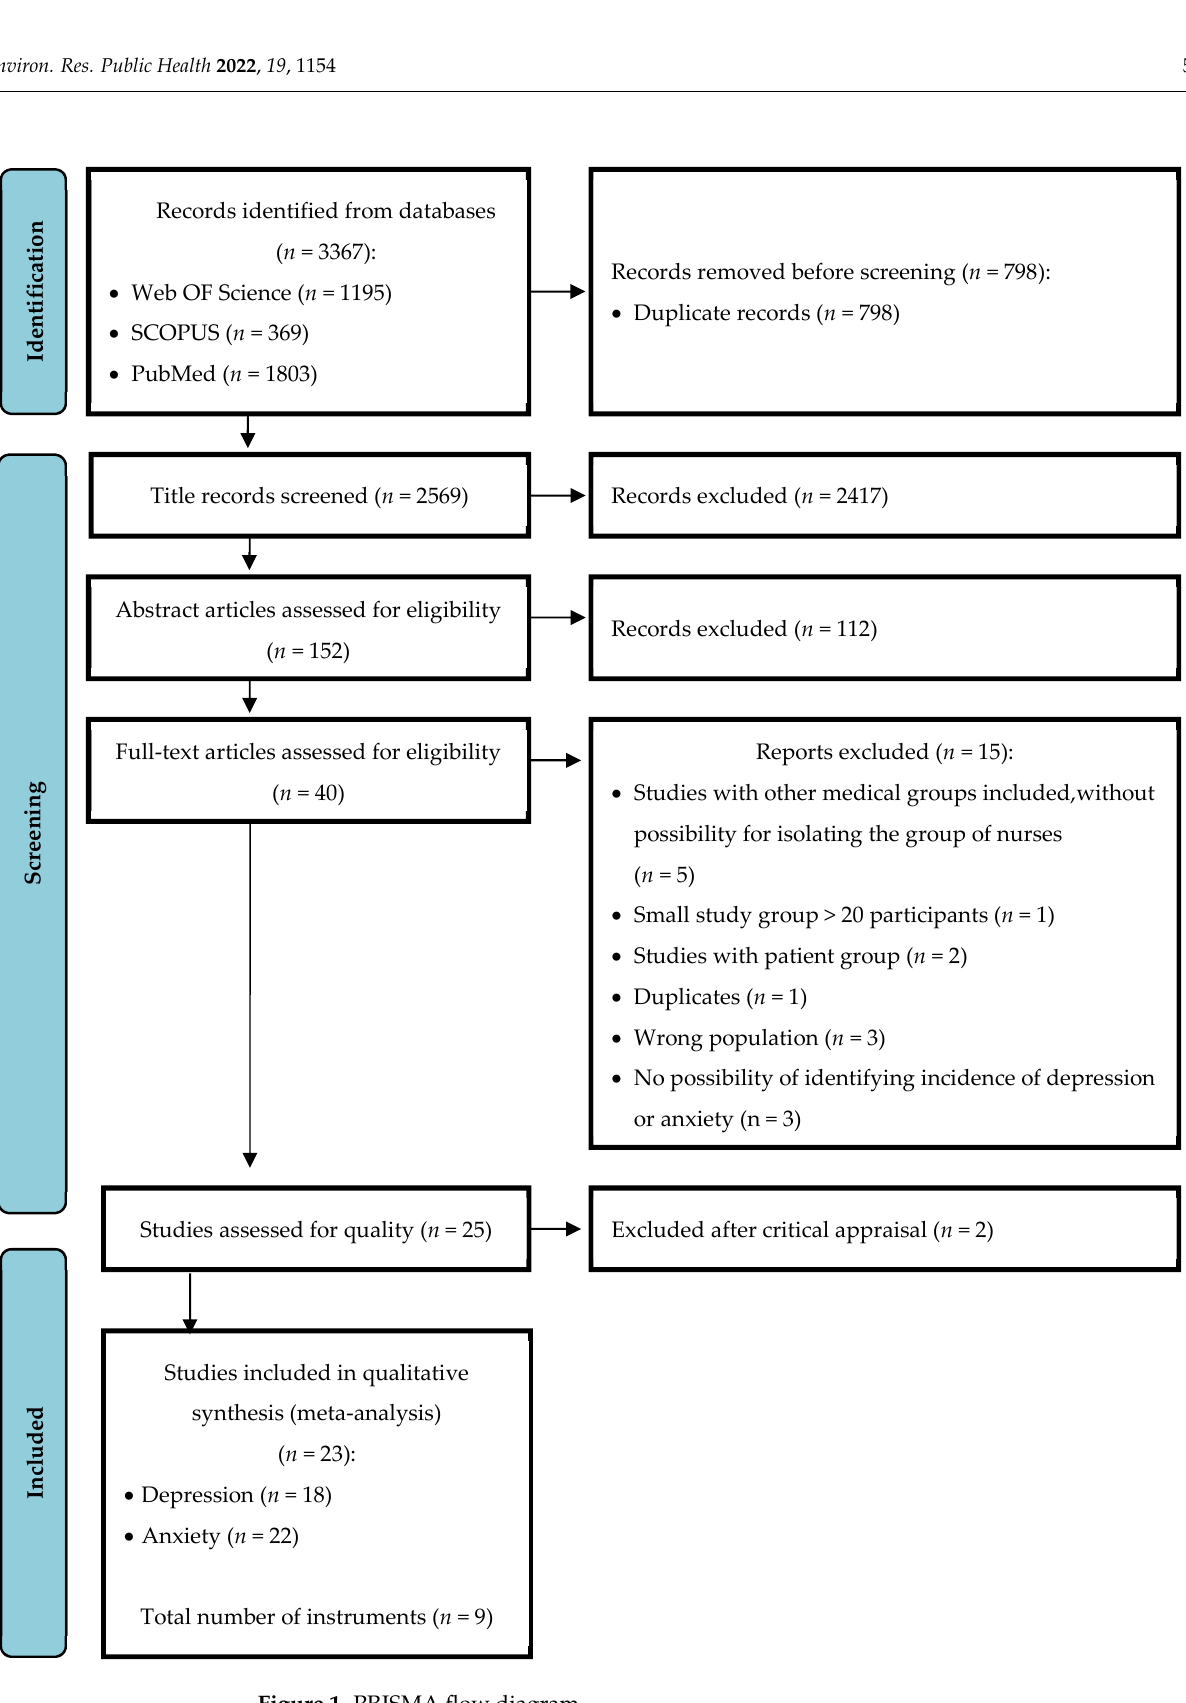
Figure 1. PRISMA flow diagram.